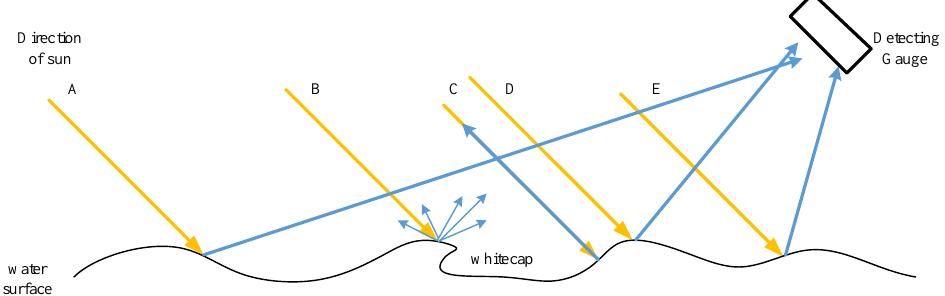
Figure 6. Schematic diagram of water surface reflection. In the case of A, C, D, and E, specular reflection is dominant, and A, D, and E may all have sun glints in the result. In case B, diffuse reflection is dominant due to the occurrence of